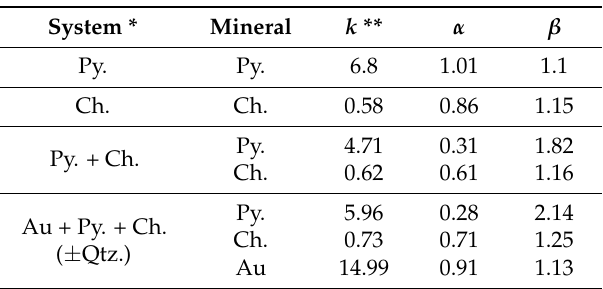
Table 3. Calibrated parameters of the kinetic